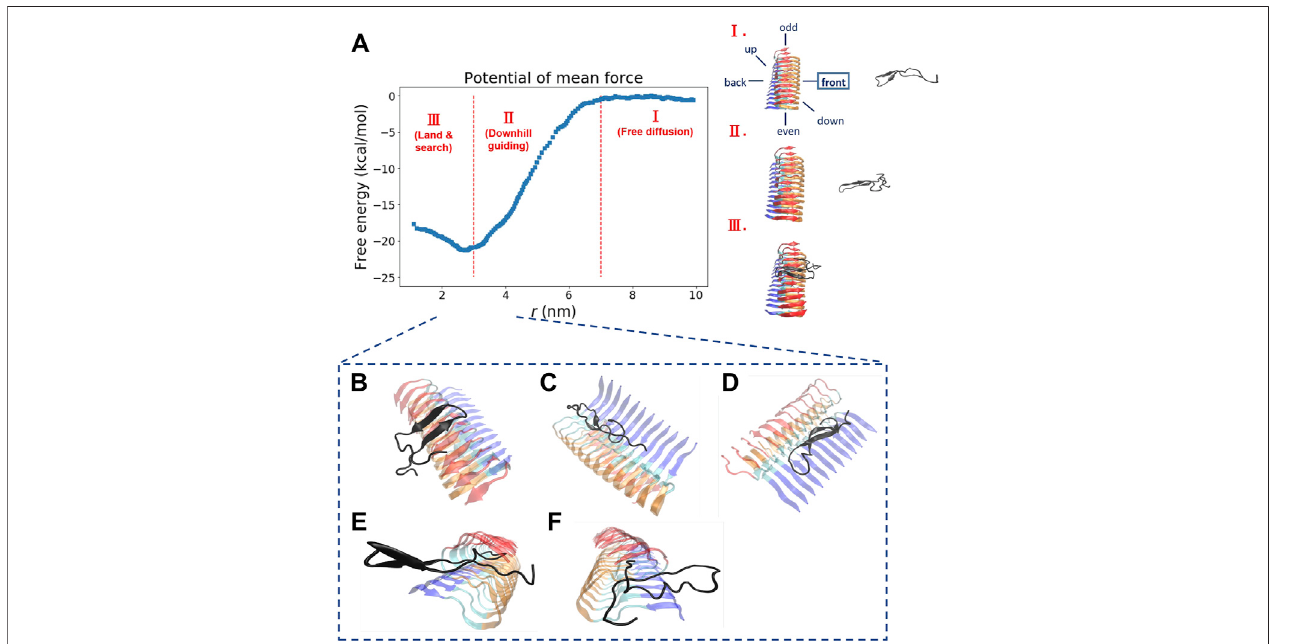
FIGURE 2 | The free energy pro fi le for a single Abeta11-42 monomer binding to the Abeta42 fi brillar surface (12 chains) is shown. (A) The free energy pro fi le features threedifferentaggregationstages,labeledasI.Freediffusion.II.Downhillguiding.III.Dockandlock. r isde fi nedasthedistancebetweentheC-betaofresidue27thinthefree monomerandtheC-betaofresidue27thofchainFinthe fi bril.Arepresentativecon fi gurationateachaggregationstageisschematicallyshownontheright.Simulationswere preparedwithsixdifferentmonomerpositionswithrespecttothecentralpre-existing fi bril.Sixorientations:front,back,up,down,even,oddareschematicallyshownin the diagram. The free energy pro fi le shown refers to the result obtained from the simulation setup with the monomer positioned in the “ front ” orientation. The free energy pro fi lesfortherestoftheorientationsareshownintheSupportingInformation( SupplementaryFigureS2 ). (B – F) TherepresentativestructurestakenfromstageIIIinwhich differentbindingcon fi gurationsareformeduponthemonomerlandingandsearchingoverthe fi brillarsurface.Thesebindingcon fi gurationsarepotentiallysurface-catalyzed precursors for fi bril growth. (B) C-ter surface precursor (C) N-ter surface precursor (D) Cleft-gate precursor (E) Even-end precursor (F) Odd-end